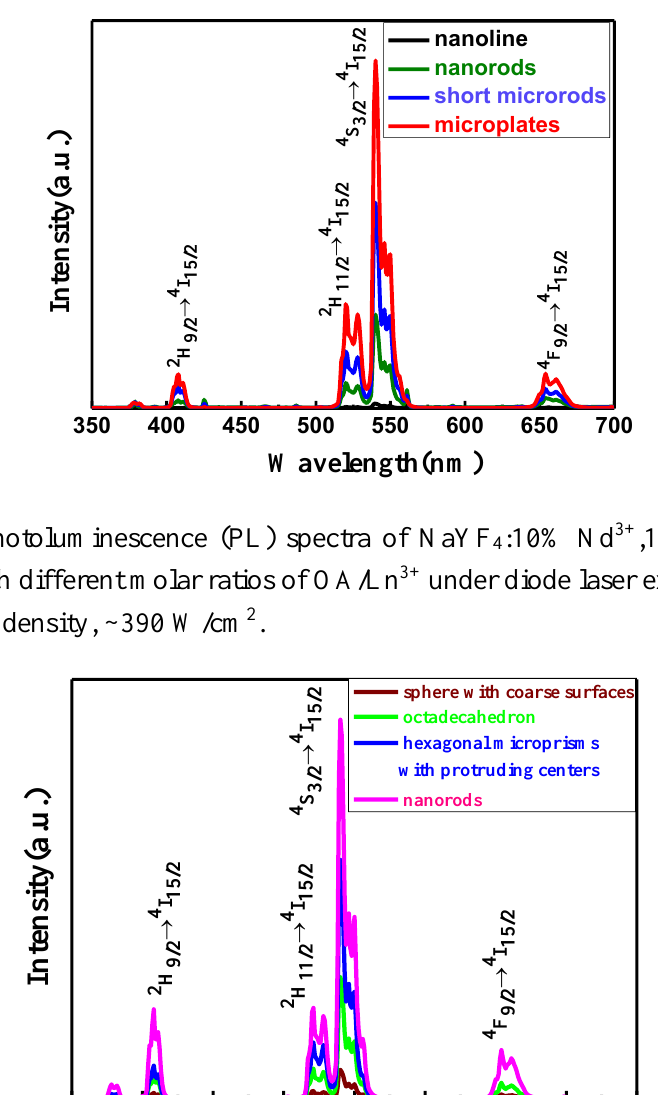
Figure 8. UC Photoluminescence (PL) spectra of NaYF microcrystals with different molar ratios of F − /Ln 3+ (180 °C, 24 h, OA/Ln 3+ = 40) under diode laser excitation at 808 nm. Excitation power density, ~390 W/cm 2